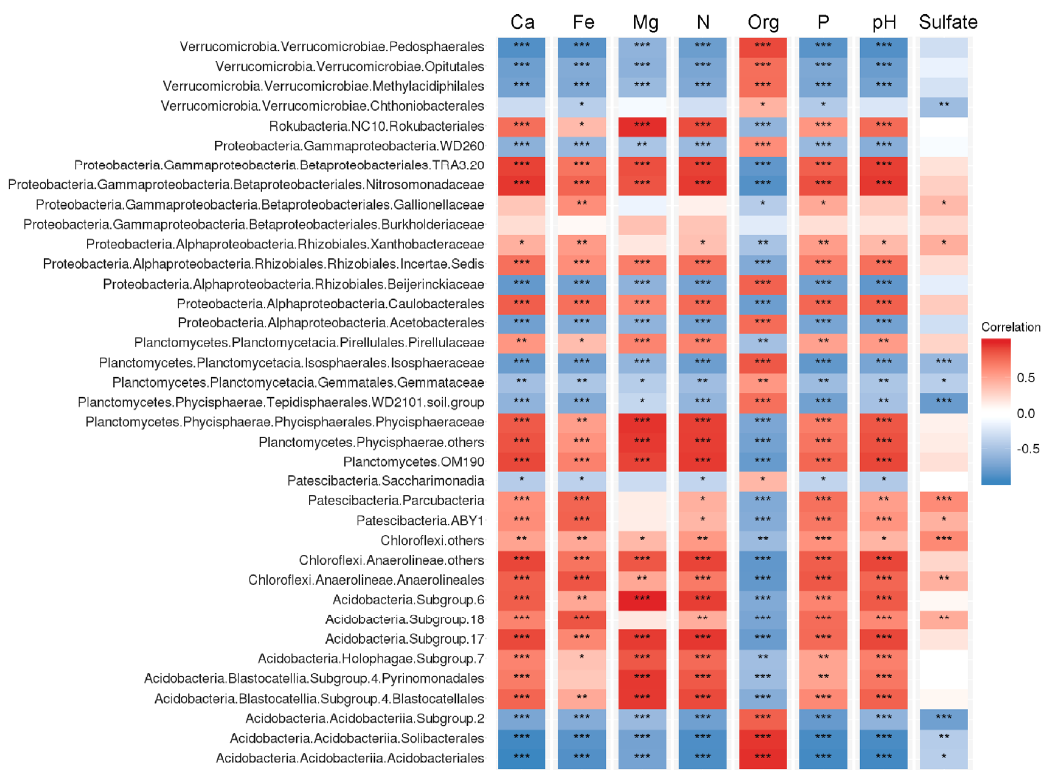
Figure 6. The correlation matrix based on Pearson’s correlation analysis between peat properties and abundance of microbial groups. The colour of rectangle represents the strength of the correlation. Correlations passing the significant level ( p < 0.05, p < 0.01, p < 0.001) were marked by one, two and three asterisks, respectively. Ca, Fe, Mg, P, - concentrations of Ca, Fe, Mg, P. Org, total organics content (%). N, total nitrogen content (%).